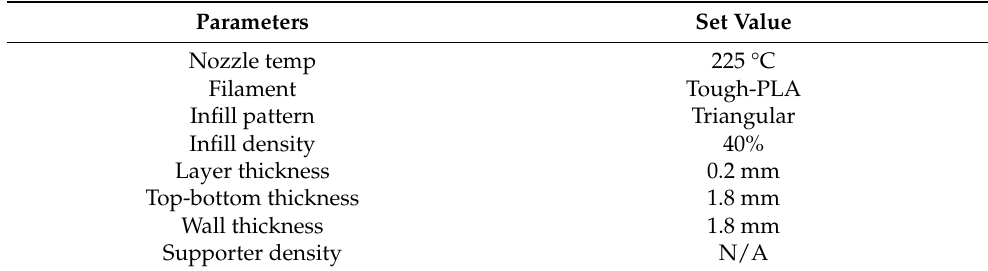
Figure 2. Schematic showing fabrication process of the SFCCM PAM in the following order: ( 1 ) The endcap parts are 3D printed with fill density of 40%. ( 2 ) The spring frames are assembled by fitting the endcaps. ( 3 ) The internal parts are sealed with an LDPE–nylon–urethane film and a high strength string. ( 4 ) Nylon–urethane film and the urethane braided mesh are assembled to the spring frame with metallic ties. ( 5 ) The outer mesh of the SFCC PAM is coated with silicon. Table 1. The set value of the 3D printing